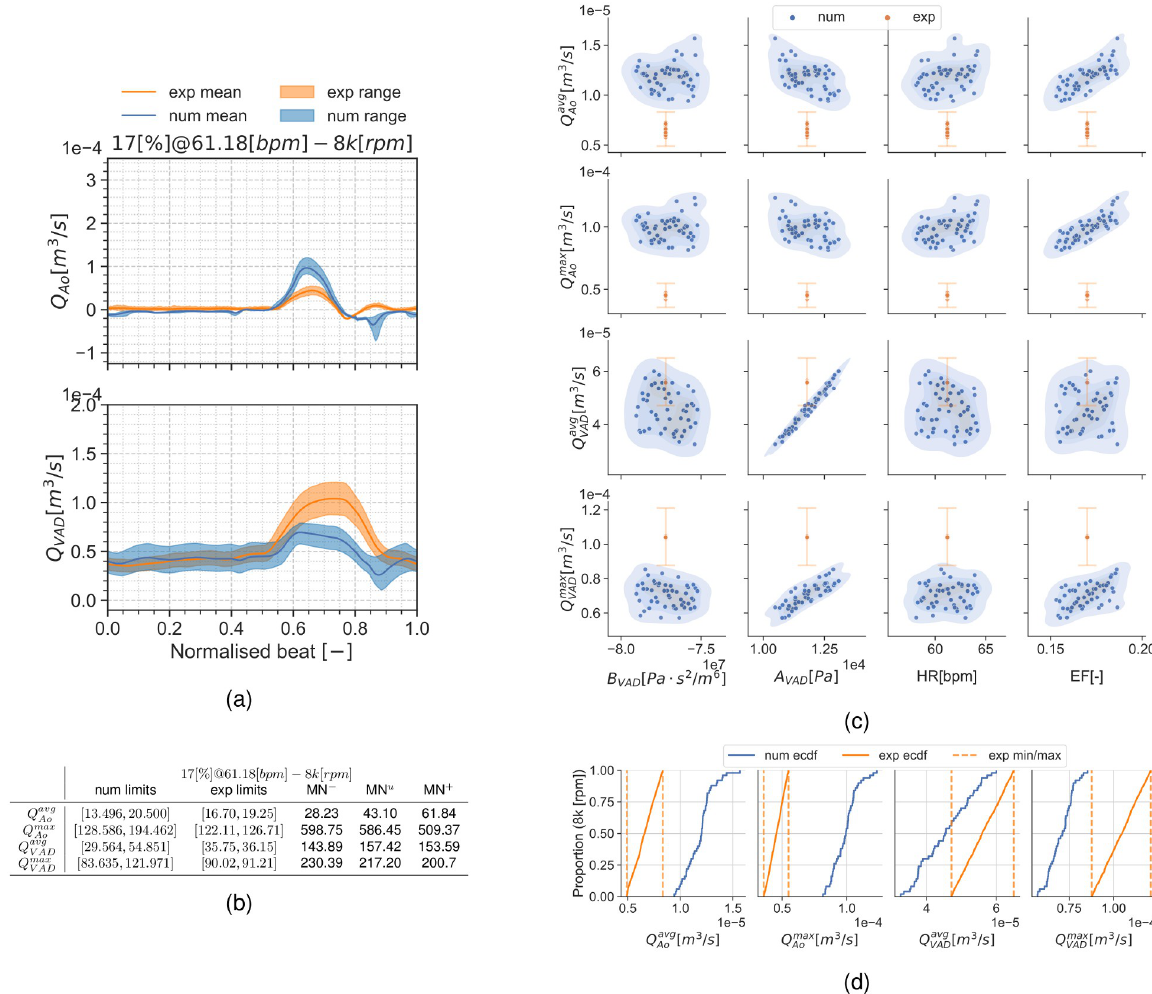
Fig 10. Summary for the condition 17[%]@61.18[ bpm ] and 8 k [ rpm ]. (a): aortic valve and LVAD flows. (b): validation metrics. (c): scatter plot showing the simulation and experimental data. (d): ECDF for the simulation, experimental data limits and the constructed uniform distribution.